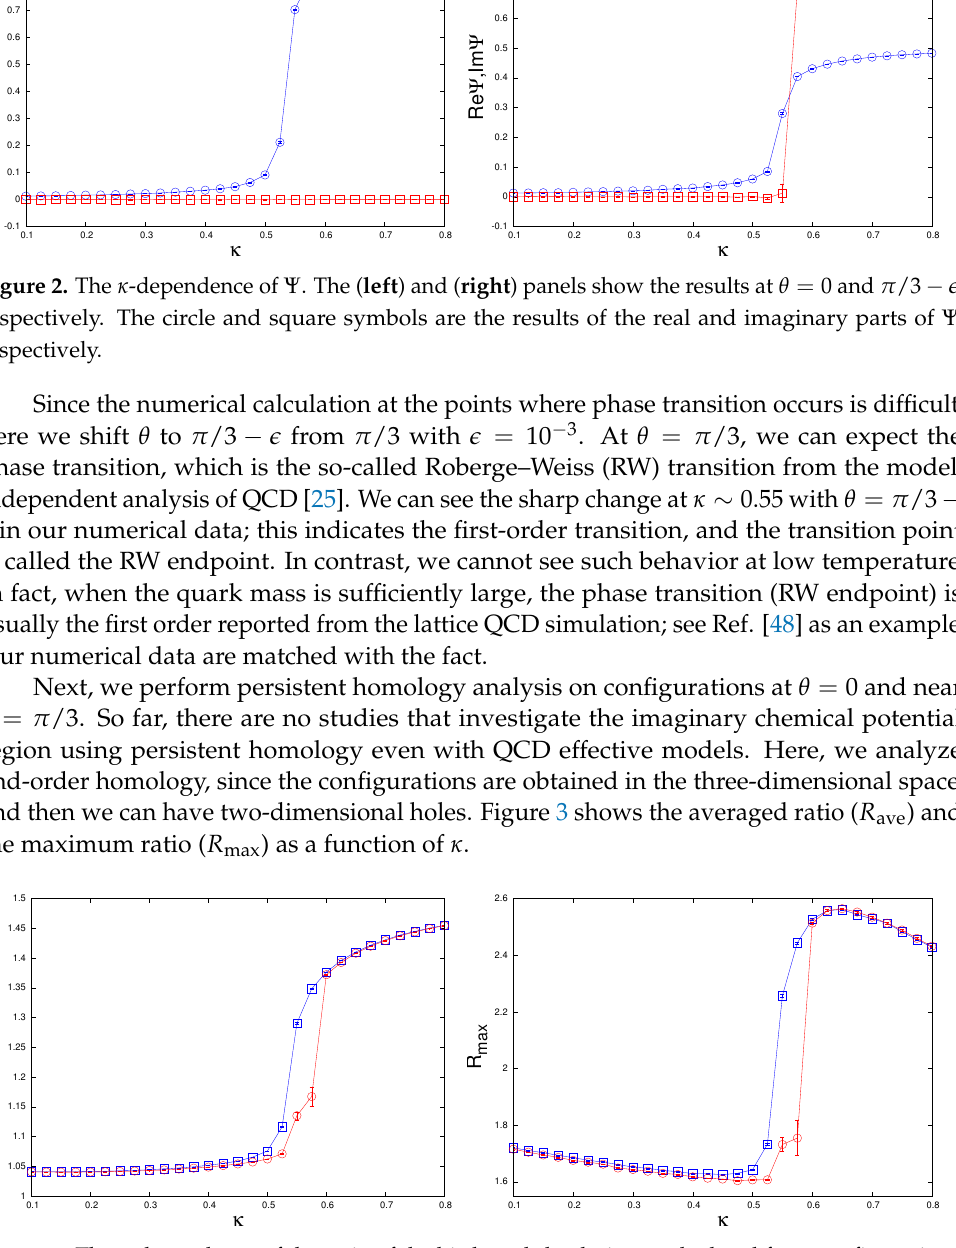
Figure 3. The κ -dependence of the ratio of the birth-and-death times calculated from configurations. The ( left ) and ( right ) panels show the results of R ave and R max , respectively. The square and circle symbols are the results at θ = 0 and π /3 − (cid:101) ,